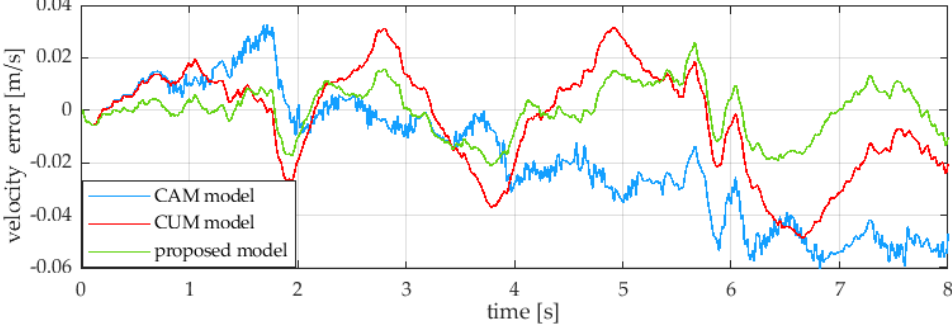
Figure 8. Absolute errors of ball velocity as a function of time for the considered numerical models.